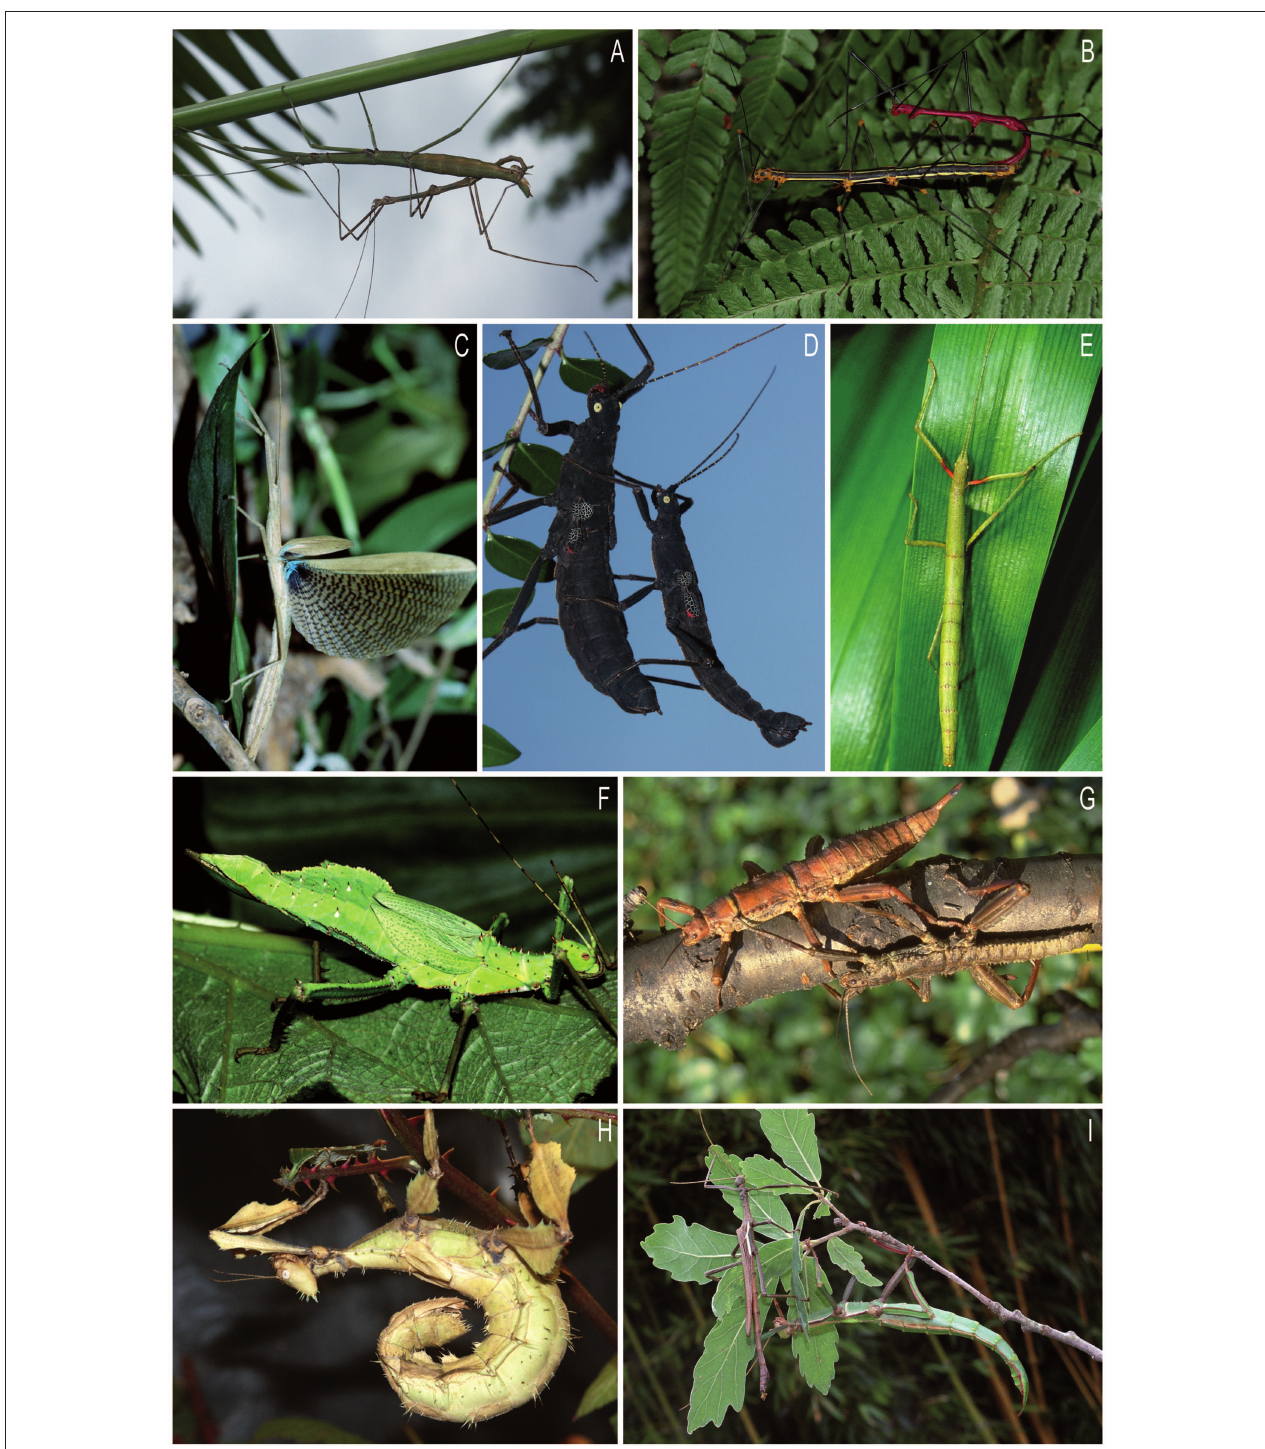
FIGURE 1 | Various members of Neophasmatodea: (A–D) : Occidophasmata; (E–I) : Oriophasmata. (A) , couple of Pseudosermyle phalangiphora , Diapheromerinae (Mexico); (B) , couple of Oreophoetes peruana , Diapheromerinae (Peru); (C) , female of Metriophasma diocles , Pseudophasmatinae (Panama); (D) , couple of Peruphasma schultei , Pseudophasmatinae (Peru); (E) , female of Carausius morosus , Lonchodinae (India); (F) , female of Heteropteryx dilatata , Heteropterygidae (Malaysia); (G) , couple of Eurycantha calcarata , Lonchodinae (New Guinea); (H) , female of Extatosoma tiaratum , Lanceocercata (Australia); (I) , couple of Diapherodes gigantea , Cladomorphinae (Grenada). Photos by Christoph Seiler, Altlussheim, Germany.